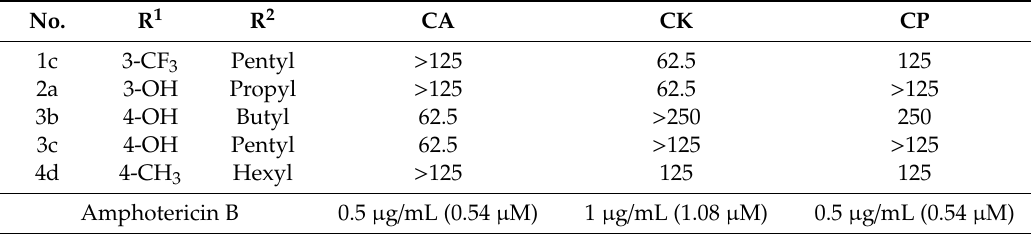
Table 3. Significant anti-candidal activity of final compounds expressed as MIC in µ